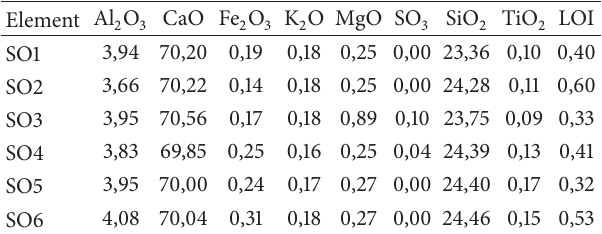
Table 2: Geochemical analyses determined by XRF expressed in terms of weight percent of oxides.